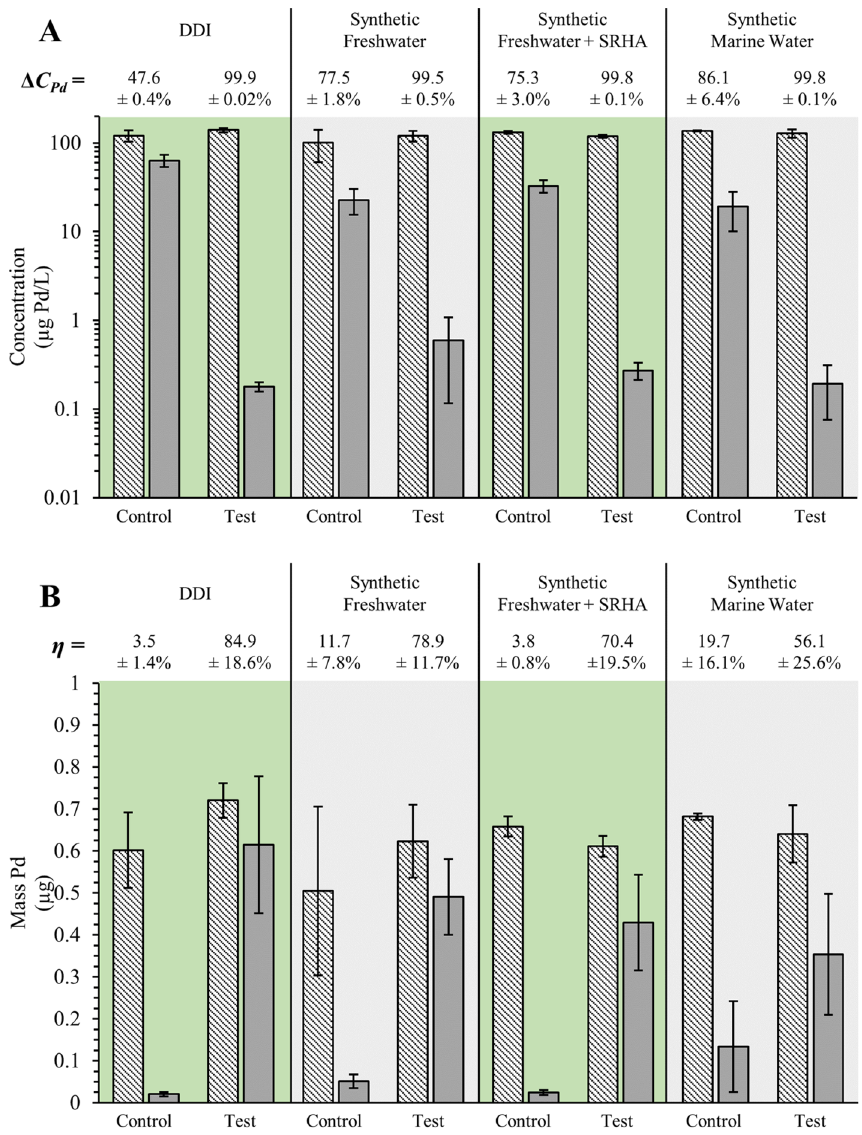
Fig. 4 PAN-Pd@PS NPs removed from suspension ( A ) and captured on the membrane ( B ) using the Magnetic Flow Cell. A Average initial concentrations (hashed) and final concentrations (solid) of PAN-Pd@PS NPs in each aquatic media after Δ t PAN-Pd@PS NPs in the initial sample (hashed) and extracted onto 10 kDa RC membrane (solid). “Control” indicates samples without NaCl and HDTMS-FeNPs while “test” indicates samples with NaCl and/or HDTMS-FeNPs. Error bars indicate